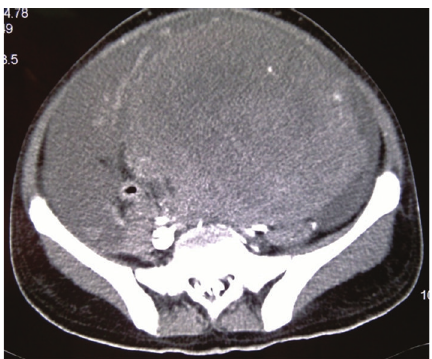
Figure 1: CT abdomen at presentation showed huge